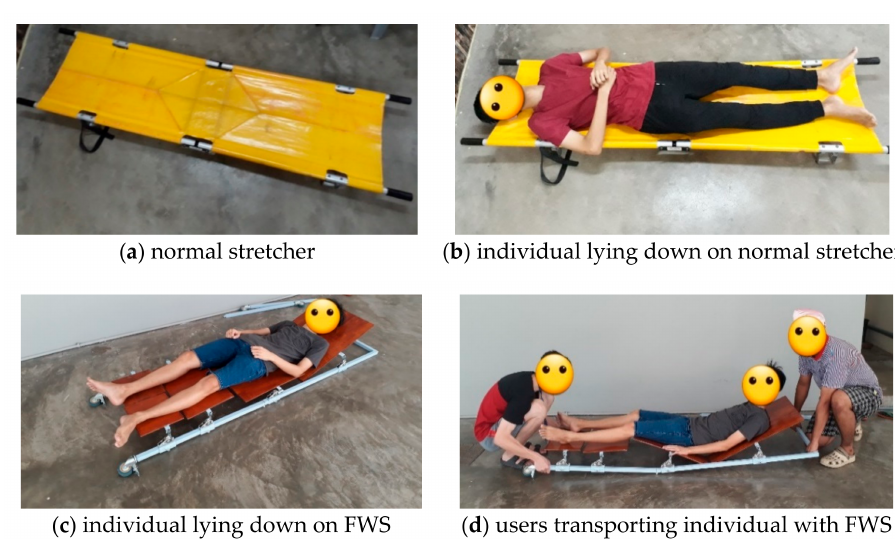
Figure 8. Test 1—comparison between the normal stretcher and FWS.